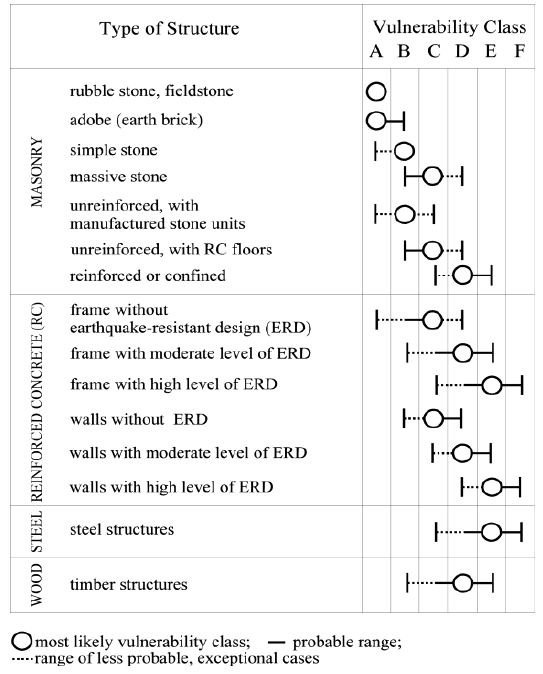
Figure 2. Vulnerability classes according to EMS-98 [22].